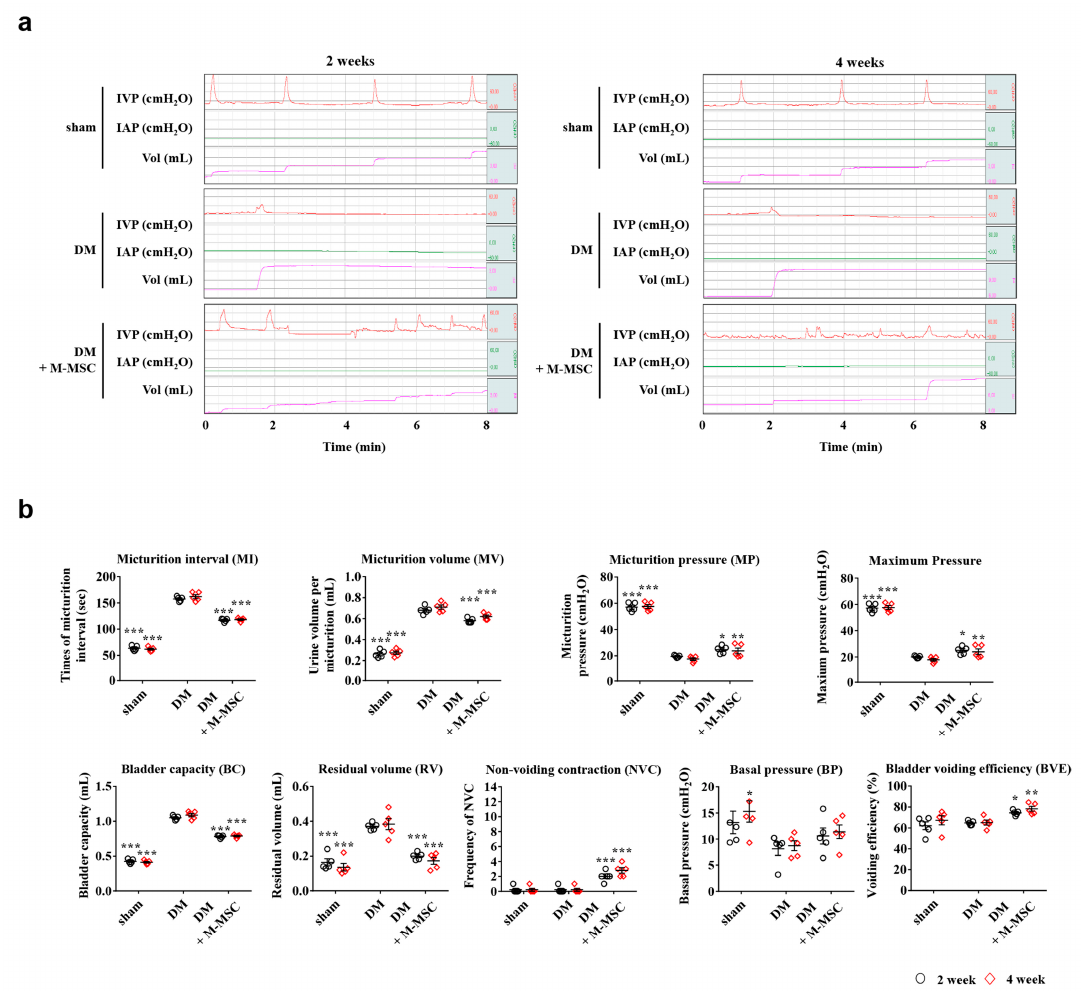
Figure 2. Long-term therapeutic e ff ects of M-MSCs in DM rats. ( a ) Representative awake cystometry results ( b ) and quantitative bladder voiding data in DM rats at 2 and 4 weeks after injection of 1 × 10 6 M-MSCs. Data are presented as mean ± SEM ( n = 5, * p < 0.05, ** p < 0.01 and *** p < 0.001 relative to DM group, two-way ANOVA with Bonferroni post-hoc comparison). The exact experimental and statistical values can be found in the Supplementary Table. DM: diabetes mellitus; M-MSC: Multipotent-mesenchymal stem